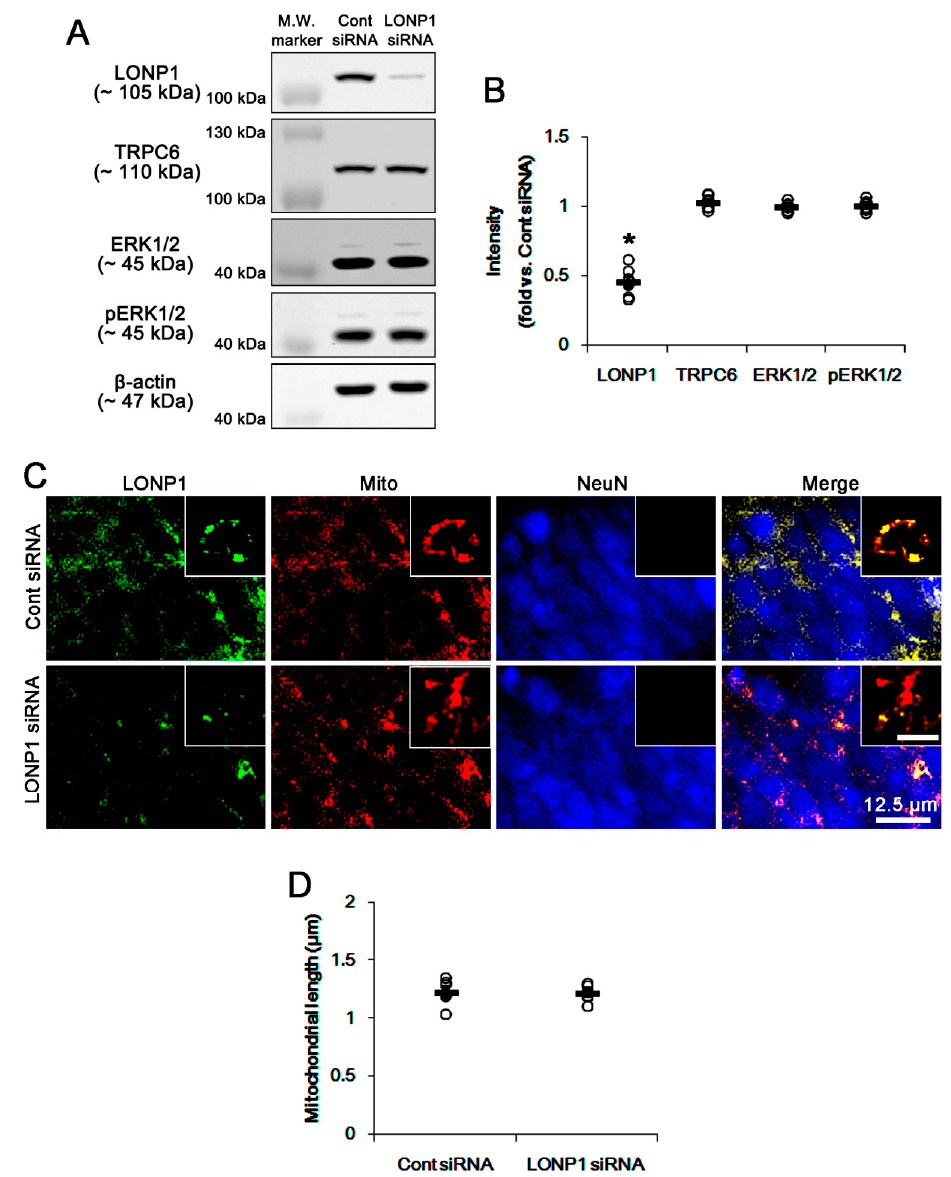
Figure 2. Effects of LONP1 siRNA on expression levels of LONP1 and TRPC6, ERK1 / 2 phosphorylation andmitochondrialdynamicsunderphysiologicalcondition. ( A , B )EffectsofLONP1siRNAonexpressions of TRPC6 and LONP1, and ERK1 / 2 phosphorylation. LONP1 siRNA decreases LONP1 expression without affecting TRPC6 expression and ERK1 / 2 phosphorylation. ( A ) Representative western blots of expressions of LONP1 and TRPC6, and ERK1 / 2 phosphorylation (M.W. marker, Molecular weight marker). ( B ) Quantification of expressions of LONP1 and TRPC6, and ERK1 / 2 phosphorylation based on western blot data. Open circles indicate each individual value. Horizontal bars indicate mean value (mean ± S.E.M.; * p < 0.05 vs. control siRNA; Student t -test; n = 7, respectively). ( C , D ) Effects of LONP1 siRNA on mitochondrial length. LONP1 siRNA does not affect mitochondrial length. ( C ) Representative double immunofluorescent images for LONP1 and mitochondria (Mito). Inserts are high magnification images (insert bar = 1.25 µ m). ( D ) Quantification of mitochondrial length. Open circles indicate each individual value. Horizontal bars indicate mean value (mean ± S.E.M.; * p < 0.05 vs. control siRNA; Student t -test; n = 7,